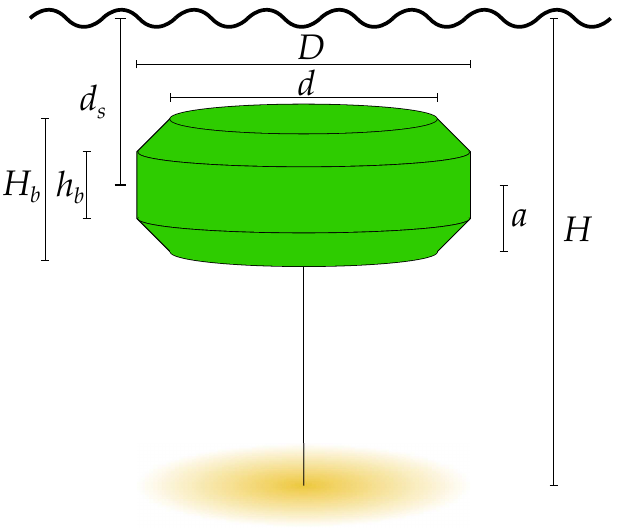
Fig. 6. A schematic of a CETO shaped buoy used in all simulated scenarios, and the definition of a number of physical quantities.